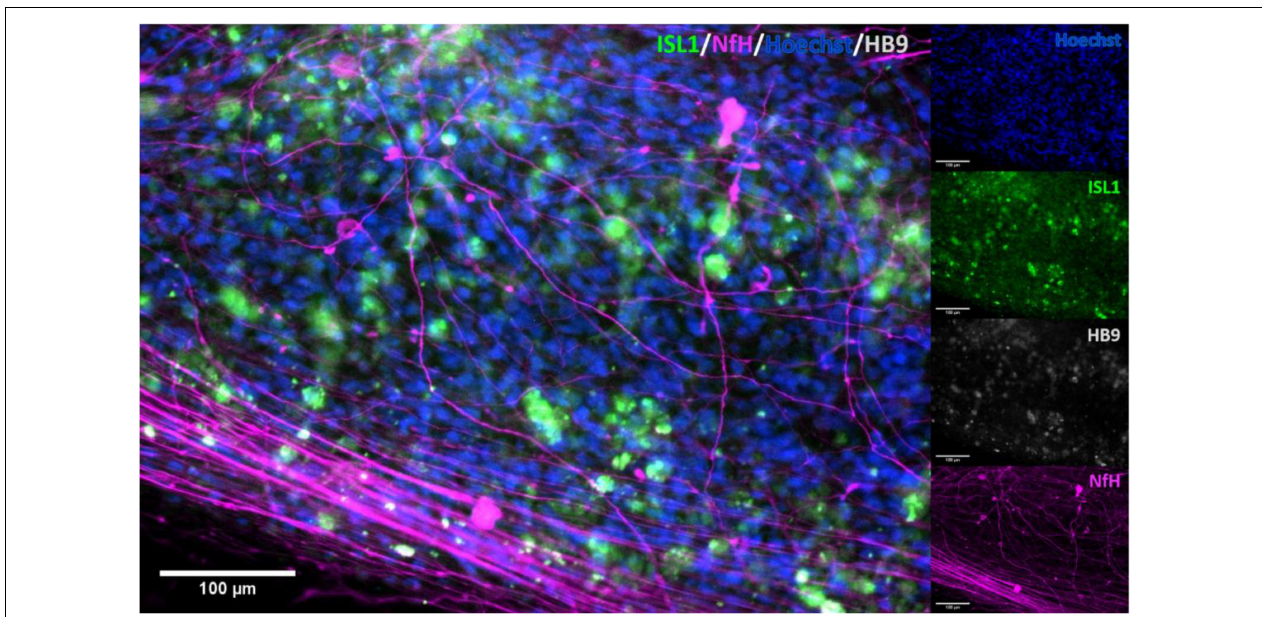
FIGURE 2 | Immunocytochemical stain for motor neuron markers. Staining for motor neuron specific markers clearly showed the presence of these in the cell cultures. Clear overlap was seen with Islet 1 and HB9, confirming the identity of the stained cells. ISL1, Islet 1; HB9, Homeobox domain 9; NfH, Heavy neurofilament.